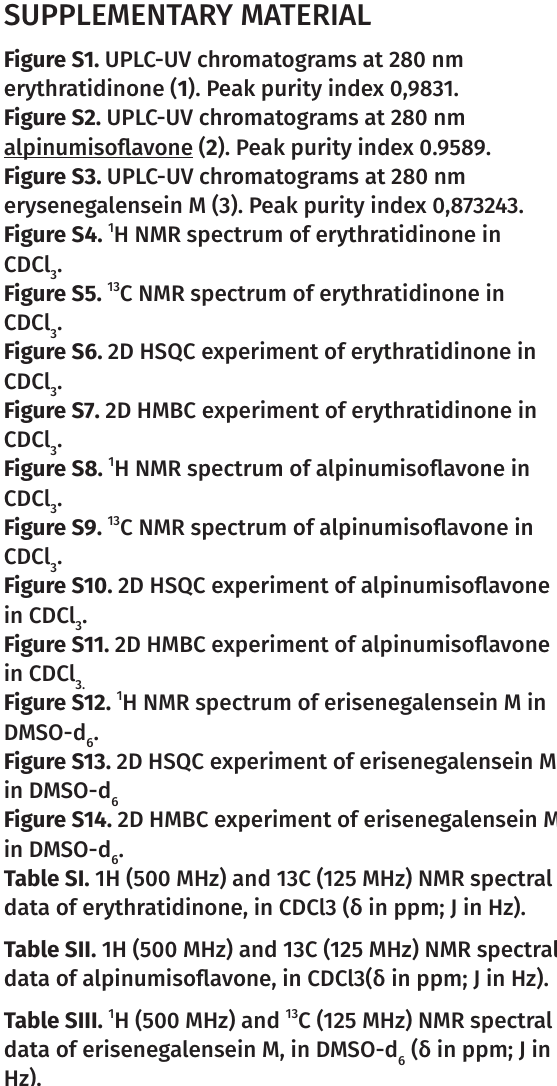
(δ in ppm; J in 6